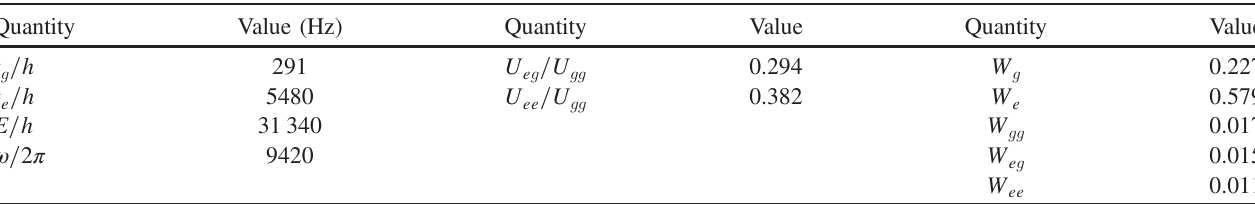
TABLE I. Tight-binding parameters used for the two-site two-band Fermi-Hubbard model [Eq. (A4)]. These include